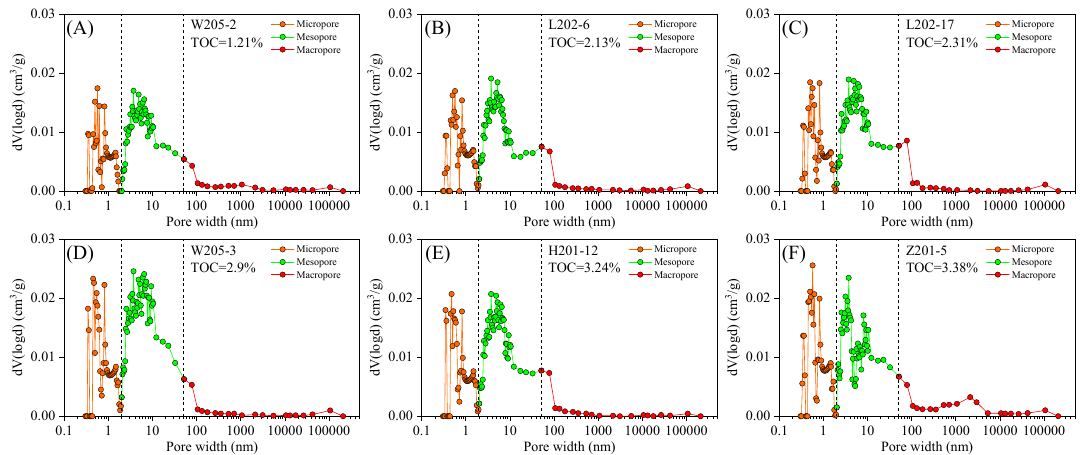
Figure 12. Combined pore size distributions (PSDs) curves of the pore volume (PV) with the date from HMIP, N2 and CO2 adsorption experiments. (A) sample W205 ‐ 2; (B) sample L202 ‐ 6; (C) sample L202 ‐ 17; (D) sample W205 ‐ 3; (E) sample H201 ‐ 12; (F) sample Z201 ‐ 5.